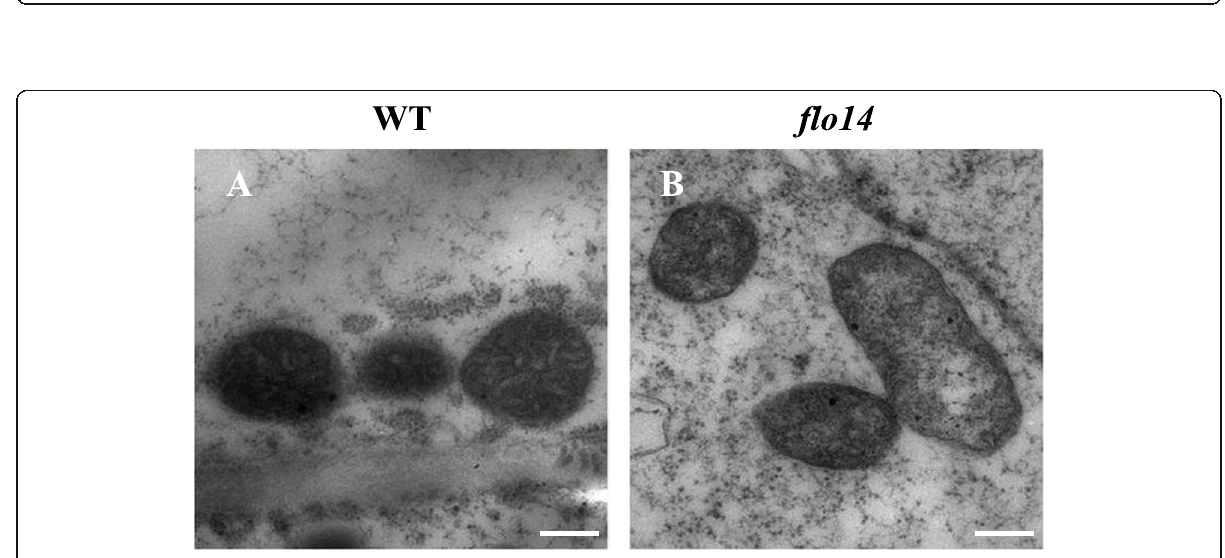
Fig. 8 Transmission electron micrographs of mitochondria. Transmission electron micrographs of mitochondria from 12 days after flowering (DAF) wild-type (WT) ( a ) and flo14 mutant ( flo14 ) ( b ) endosperms. Scale bars: 1 μ m in ( a ) and ( b